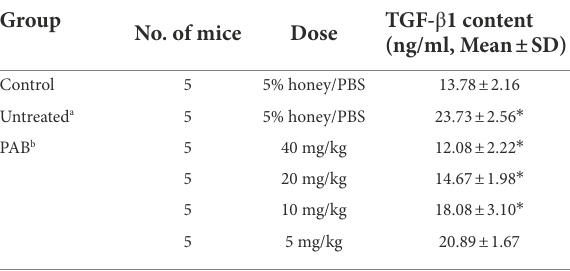
TABLE 2 Changes of TGF- β 1 content in the serum of E. multilocularis- infected mouse orally treated with PAB for 12 weeks after 3 months post-infection. Group